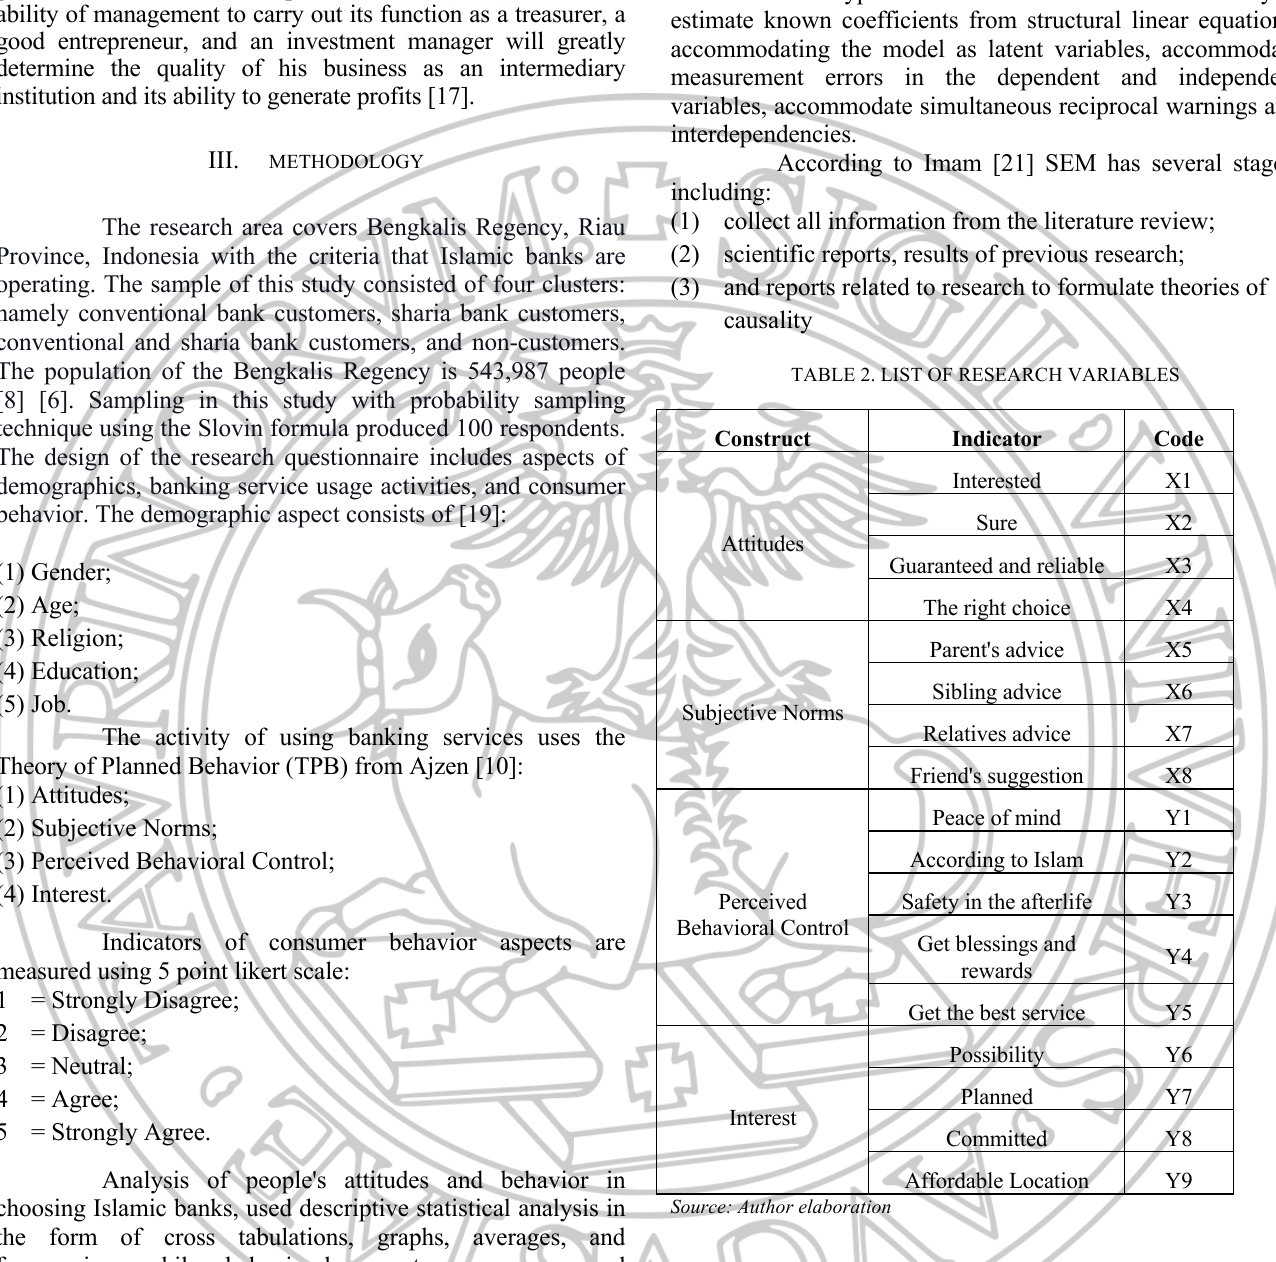
TABLE 2. LIST OF RESEARCH